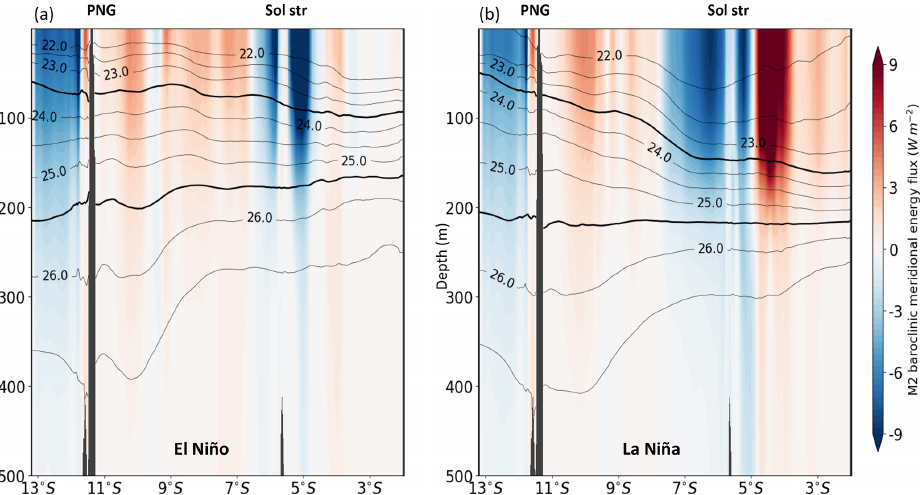
Figure 11. Vertical section at 154 ◦ E of the mean meridional energy flux estimated during (a) El Niño state and (b) La Niña state (units: watts per square meter). The corresponding isopycnals are in contours, with σ = 23 . 5 and σ = 24 . 5kgm − 3 in bold.